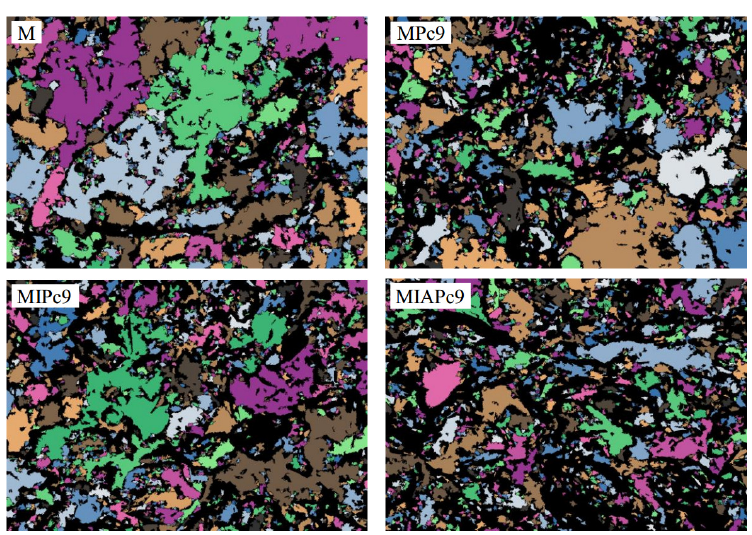
Figure 8. Pore vector images from PCAS corresponding to the SEM micrographs at 2000 × . Quantitative data in Table 4 also suggests that sample MIAPc9 had the best curing effect among the three types of cement solidified samples. Compared to the natural soil of sample M, the maximum pore area decreased by 75.41%, the total pore area decreased by 37.42%, and the actual porosity reduced by 38.18% for sample MIAPc9. On the other hand, the curing effect of sample MIPc9 was lower than that of sample MPc9. This may be due to the acid-base neutralization reaction between ISS and cement. All the